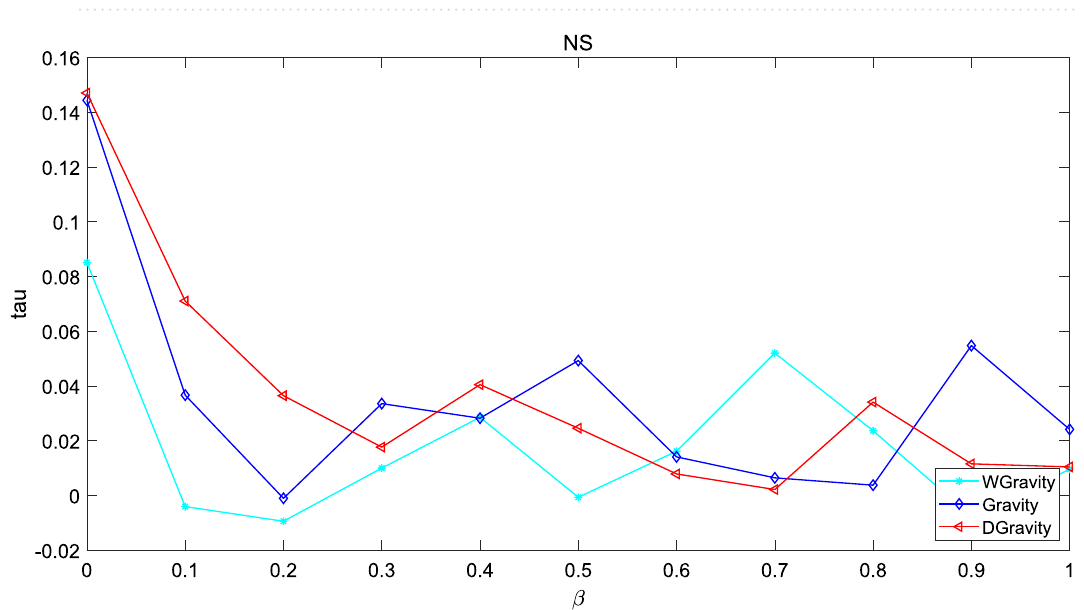
Figure 15. This figure describes the correlation between the methods based on gravity model and the standard sequence generated by SI in Jazz. The new model performs better when β is in the interval 0.55–0.8. Gravity model shows the worst performance.